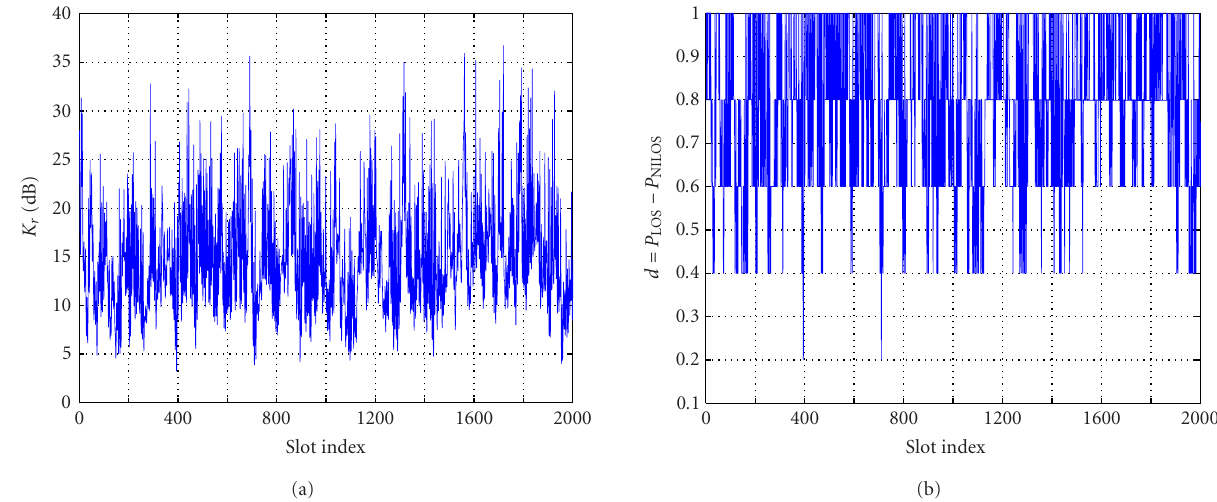
Figure 6: Estimated Rician factor K r (plot (a)) and the probability distance d (plot (b)). Channel profile Rician with K r = 15 . 5dB and v = 22 . 22m/s.